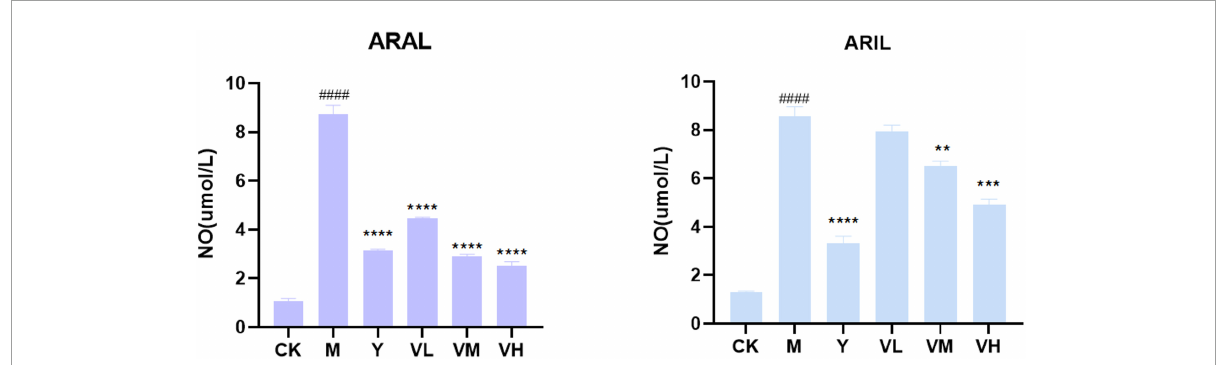
FIGURE12 Effect of A. argyi and A. indica on NO production in RAW264.7 macrophages. The content of LPS group increased and decreased after administration (means ± SD , n = 3 ). **** P < 0.0001, *** P < 0.001, ** P < 0.01 compared with that of the LPS group; #### P < 0.0001 compared with that of the control group.